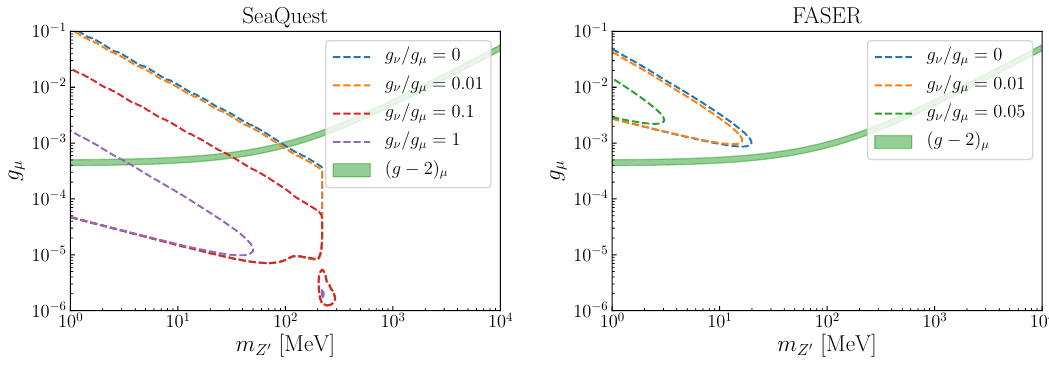
Figure 5 . Similar to the right panel of figure 4, this time for SeaQuest (left) and FASER (right).